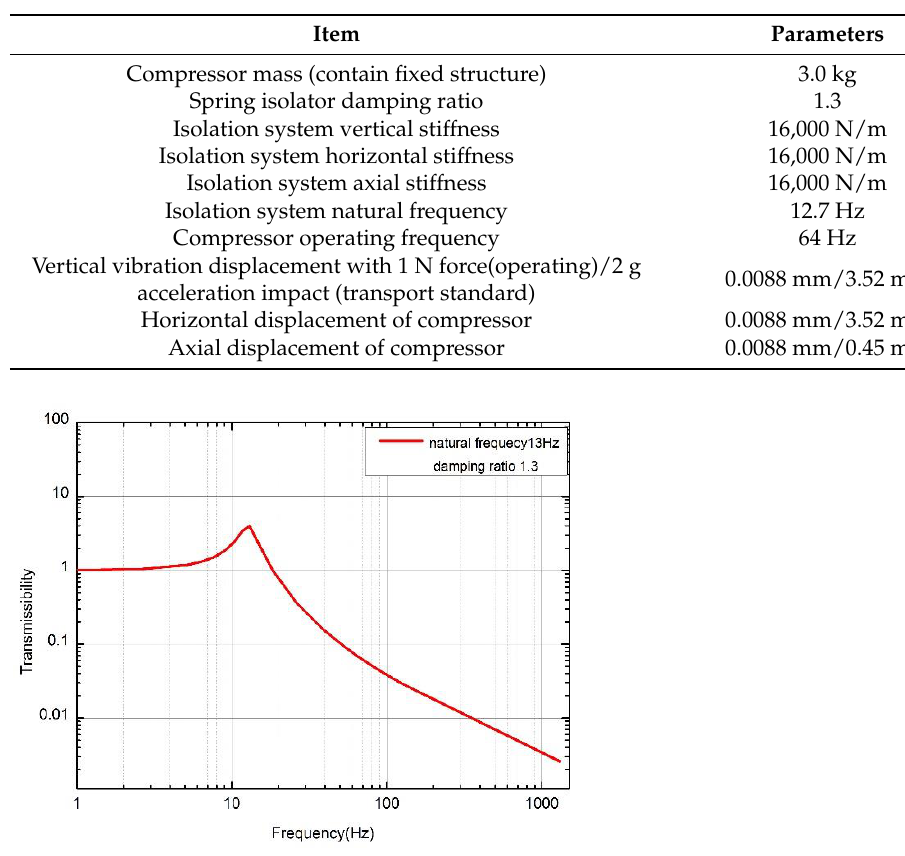
Figure 3. The transmissibility of the compressor isolation system.